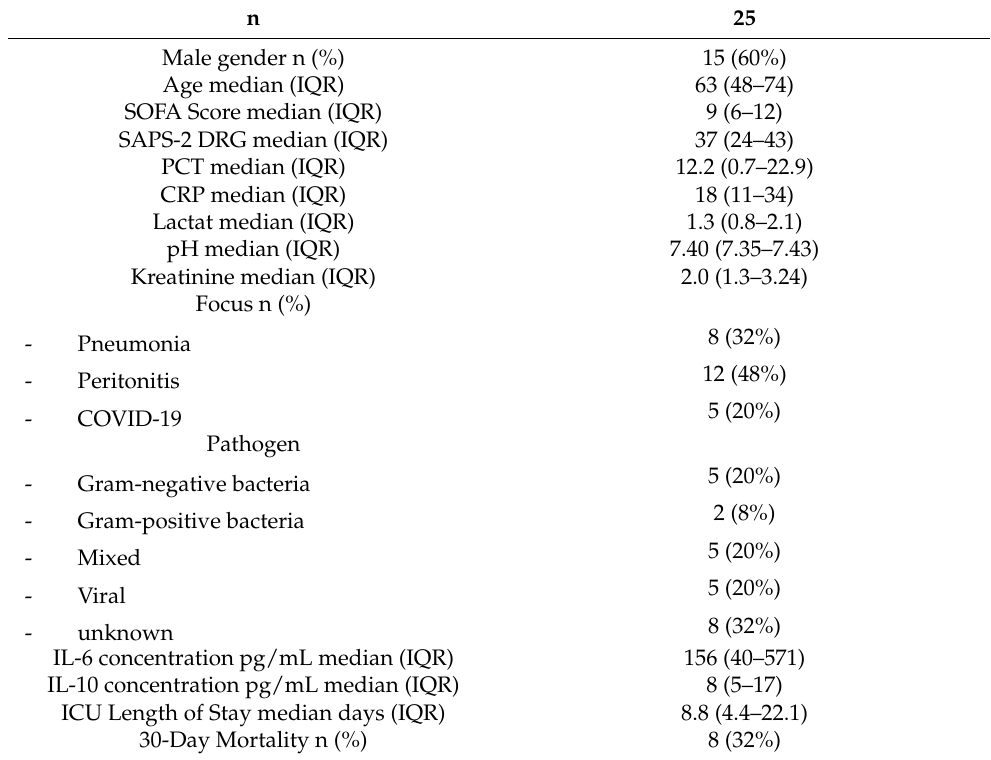
Table 1. Base characteristics of 25 critically ill patients included in this